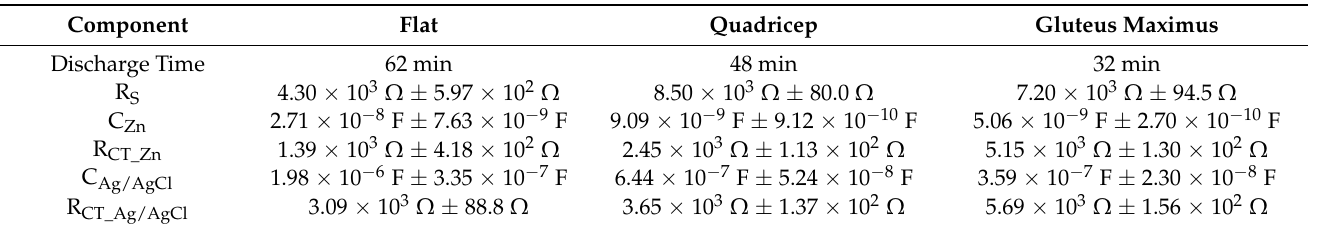
Table 2. Equivalent Circuit Fit Values for the Flat, Quadricep, and Gluteus Maximus Strained 9-Cell Battery.